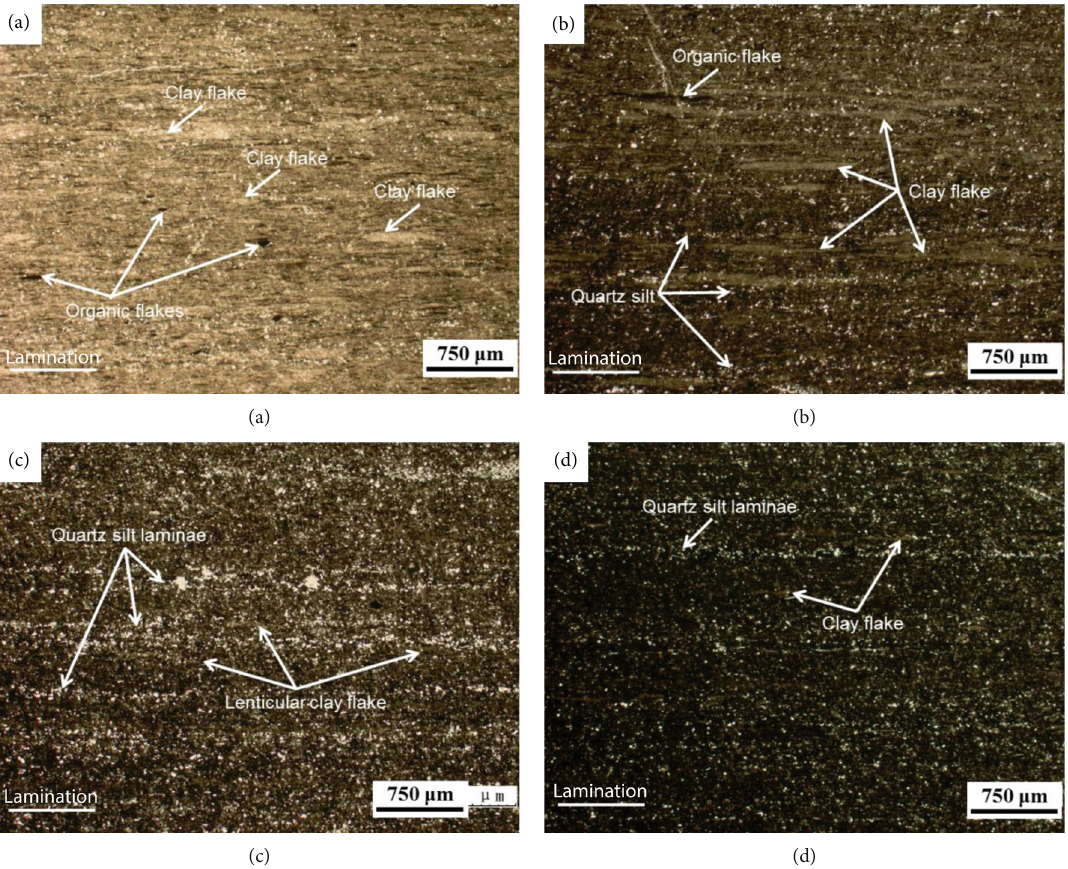
Figure 6: Transmitted light thin section images of silica-rich argillaceous shale lithofacies (CM). (a) Long striped clay fl akes distributed along the lamination. Minor organic fl akes are intermittent along the lamination. No obvious laminae of silty quartz are observed. JYA-2, K h = 76 : 6 μ D , permeability anisotropy ð β Þ = 13 : 4 , 2531.09m. (b) Long striped and lenticular clay fl akes distributed along the lamination. Organic fl ake along the lamination is observed. Clay fl akes are dyed by organic matters. Minor laminae of silty quartz are intermittently along the lamination. JYA-3, K h = 64 : 7 μ D , permeability anisotropy ð β Þ = 49 : 8 , 2537.09m. (c) Intermittent laminae of silty quartz. Miniature lenticular clay fl akes are along the lamination. JYA-4, K h = 2 : 0 μ D , 2540.47m. (d) Slight laminae of silty quartz. Miniature lenticular clay fl akes are along the lamination. JYA-8, K h = 7 : 8 μ D , permeability anisotropy ð β Þ = 10 : 6 ,